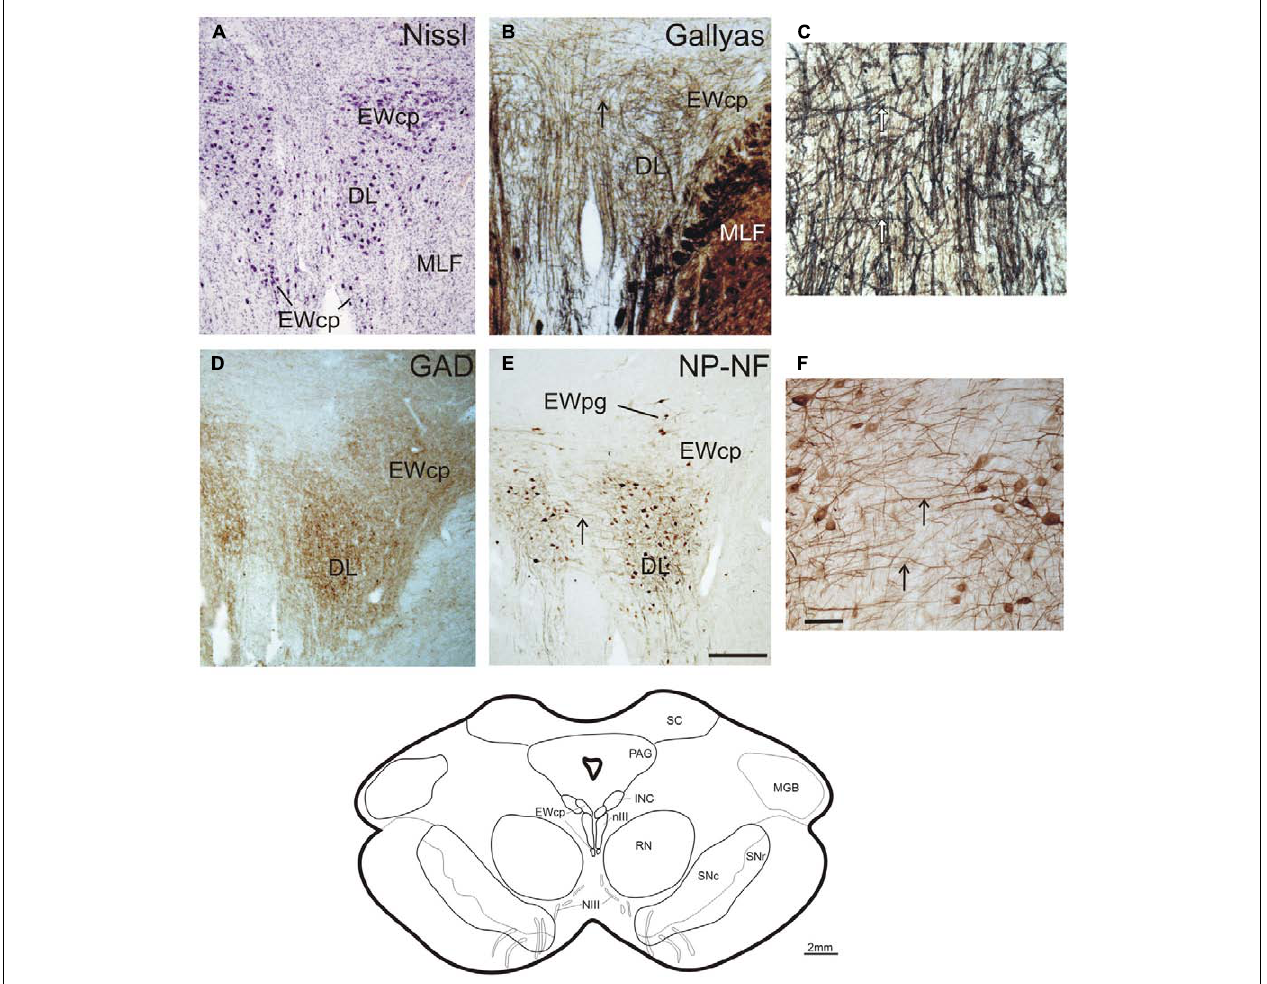
FIGURE 5 |Transverse sections at the level of the rostral oculomotor nucleus (line drawing at the bottom). Cresyl violet (A) , Gallyas-fiber staining (B) with detail (C) , immunostaining for glutamate decarboxylase (GAD) (D) , and non-phosphorylated neurofilaments (NP-NF) (E) with detail (F) . Note, unlike the preganglionic neurons of the Edinger–Westphal nucleus (EWpg), the centrally projecting non-preganglionic neurons of EWcp do not express non-phosphorylated neurofilaments (NP-NF) (C) .The strong labeling